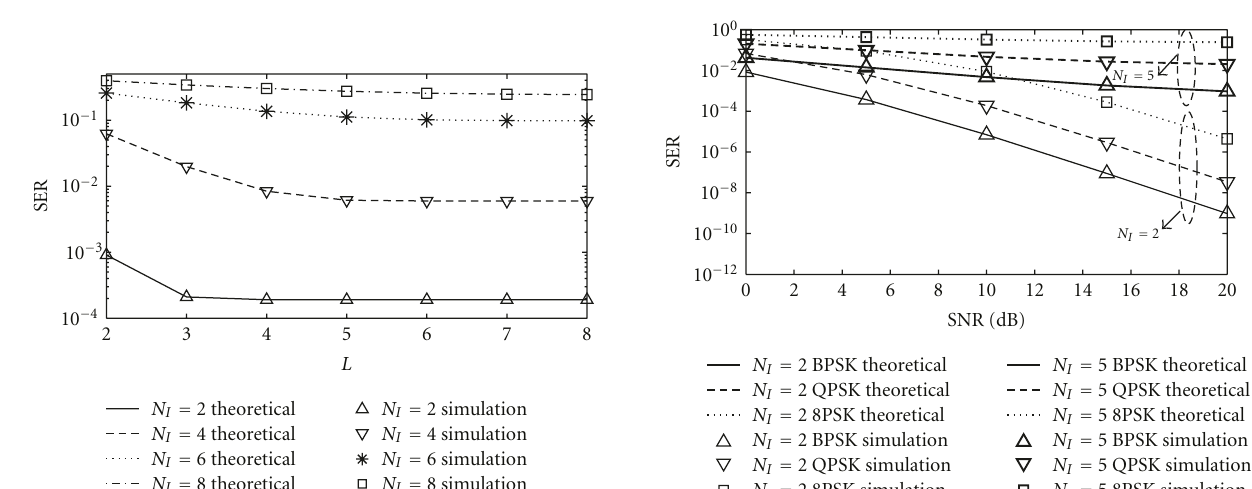
Figure 3: SER versus K with di ff erent values of N I when L = 6, SIR = 0dB, and SNR = 10dB.